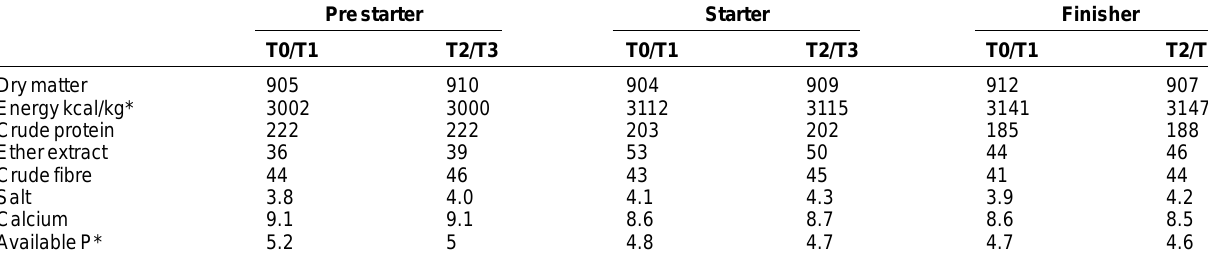
Table-1. Composition of the basal and experimental diets (in g/kg unless stated